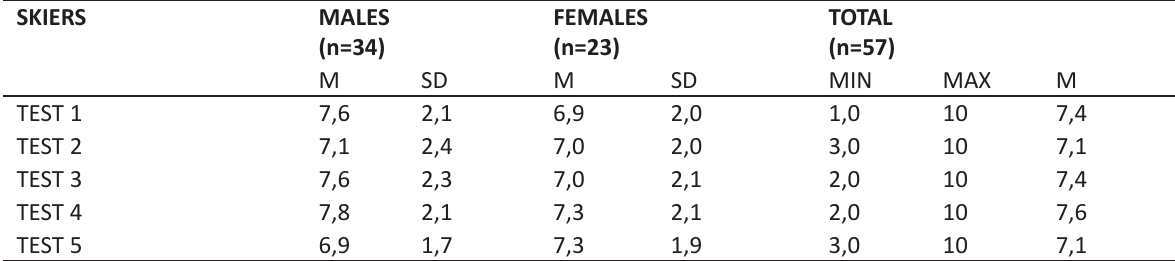
Table 1. The results of tests in relation to sex.